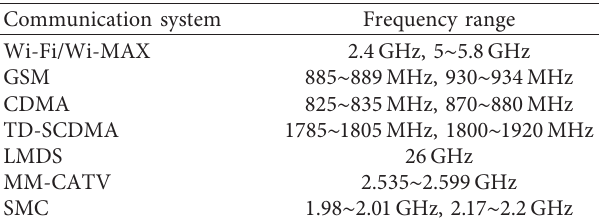
Table 1: Frequency range distribution table of the communication system